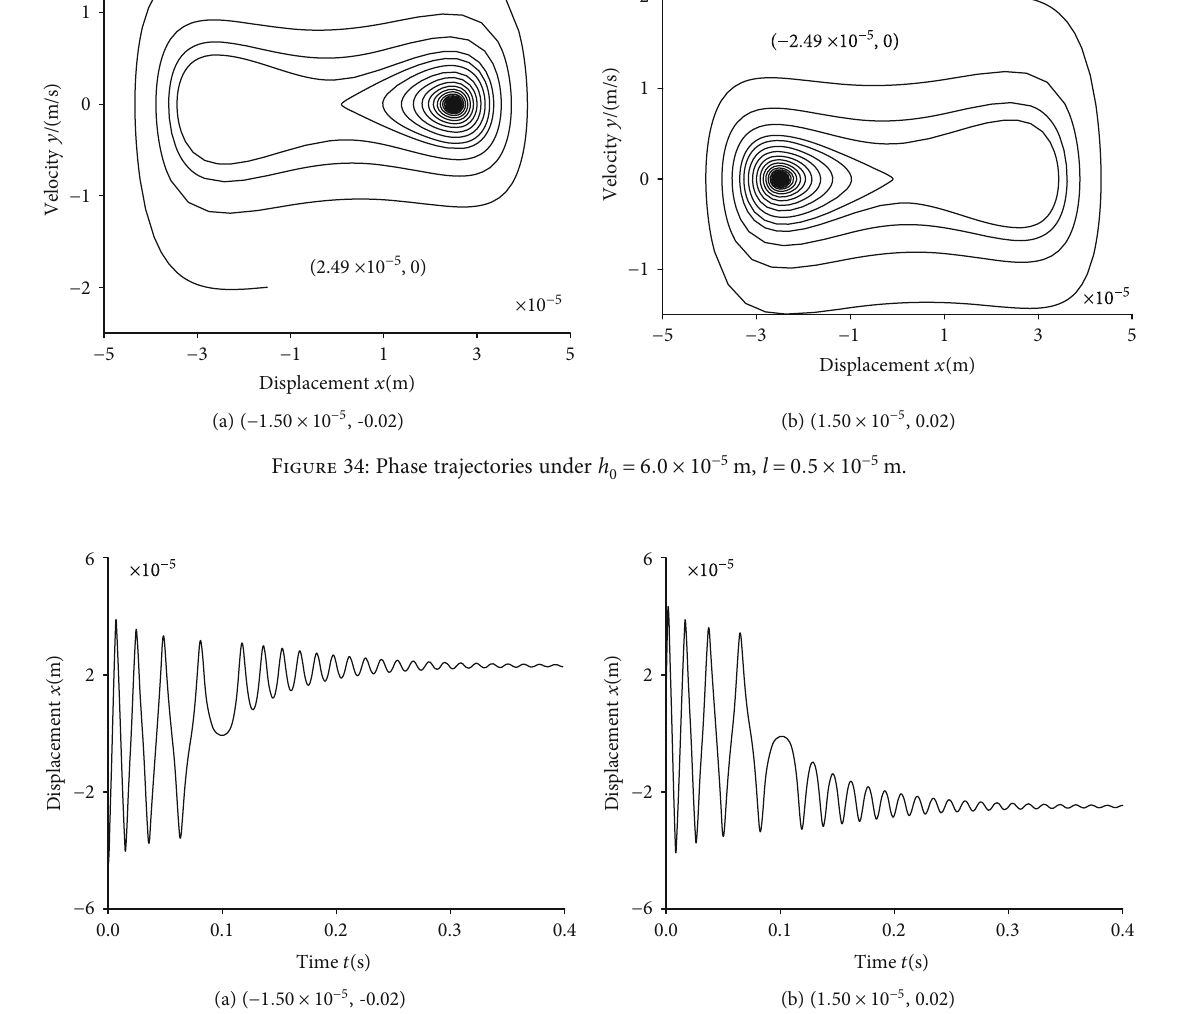
Figure 35: x − t curves under h